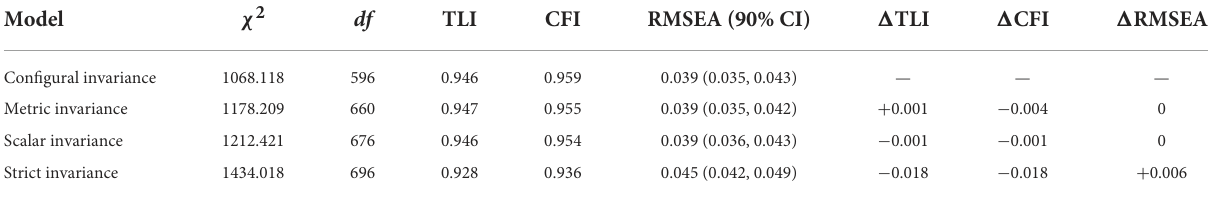
TABLE 6 Multi-group ESEM comparison nested model fitting index (longitudinal invariance, N = 519). Model Configural